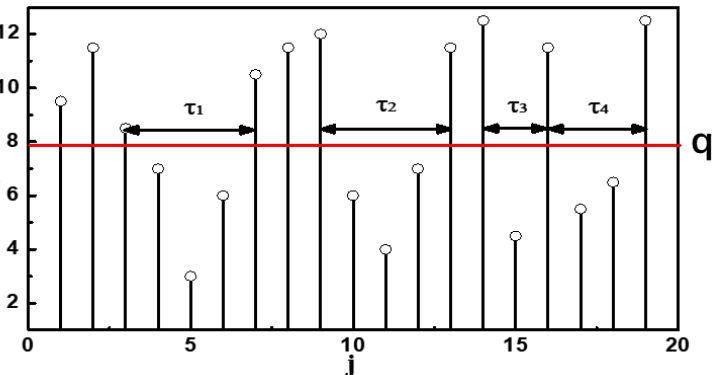
Figure 2. Pictorial definition of quiet time τ . The red line represents the precipitation threshold q , while τ 1 , τ 2 , τ 3 and τ 4 are the corresponding quiet times.